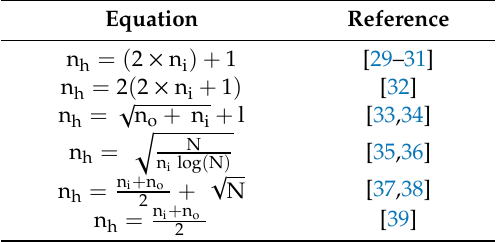
Table 1. Rule of thumb equations for the estimation of the number of hidden layer